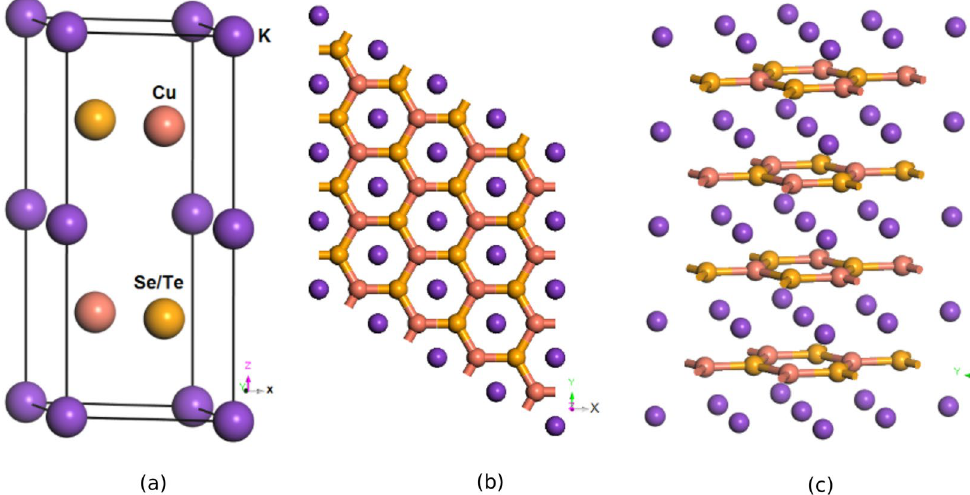
Figure 1. Optimized crystal structure of KCuX ( a ) A perspective view of unit cell orient towards xz plane ( b ) 2D view along xy plane showing honeycomb lattices formed by Cu and Se/Te with AB stacking and K located at the inversion center ( c ) layered structure orient towards yz